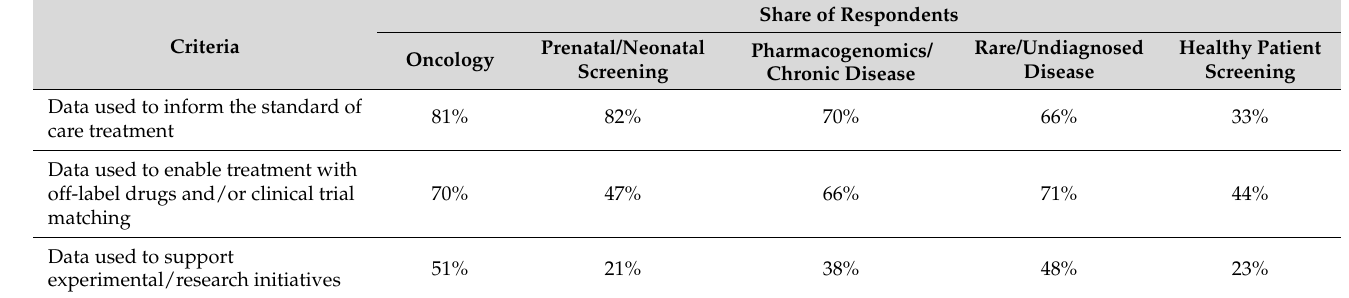
Table 4. Utilization of data.